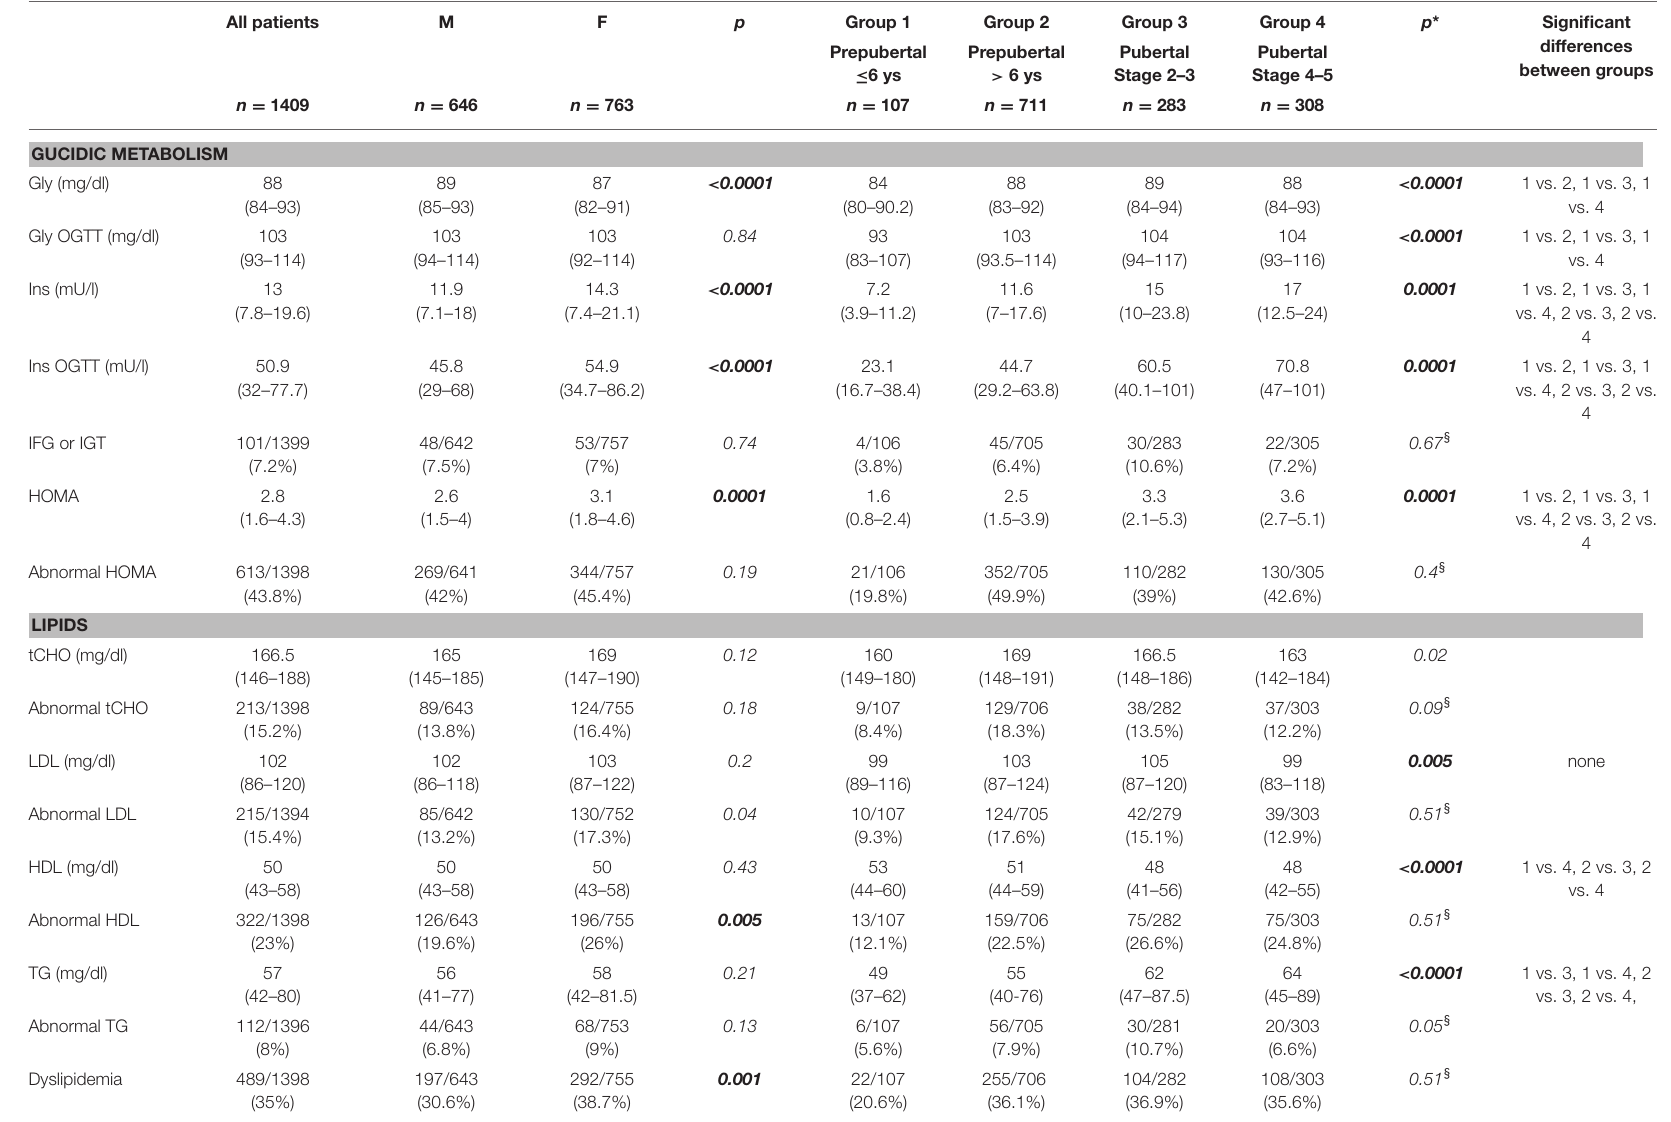
Data are reported as median and IQR or count and percentage. * Adjusted for BMI-SDS. § p-value refers to “pubertal groups” variable considered as an independent variable in the logistic regression model. Bold values refers to statistically significant differences among groups. Italic values were used to make p-value easily